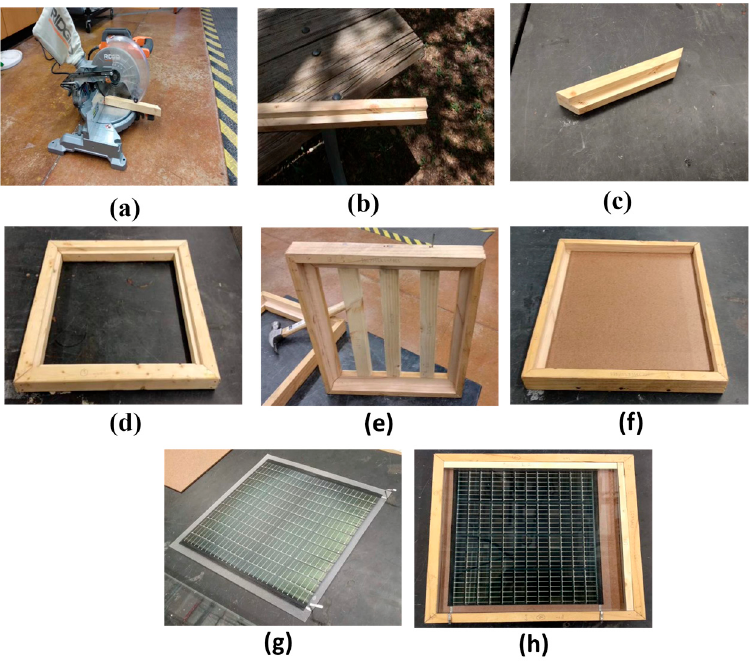
Figure 2. Fabrication steps for the solar panel. ( a ) 45 ◦ angle cutting, ( b ) grooved cut sample, ( c ) 45 ◦ angle cut grooved sample, ( d ) rectangular hollow frame, ( e ) rectangular frame with stiffeners, ( f ) rectangular frame with hardboard, ( g ) thin film solar cell, and ( h ) assembled solar panel [37,38].